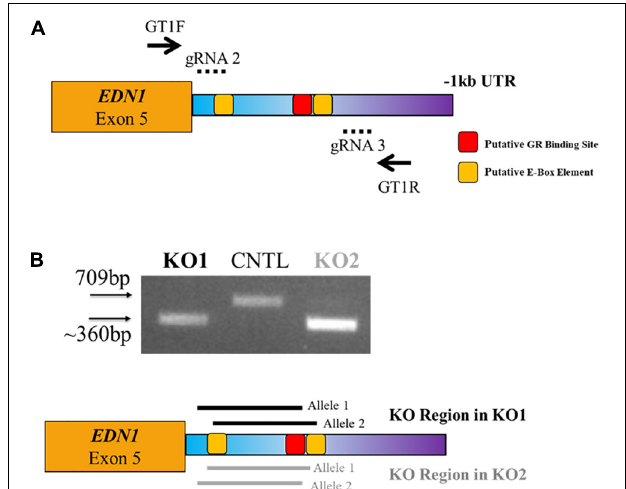
FIGURE 6 | CRISPR/Cas9 Targeted Deletion of GR and E-Box Regulatory Elements within the EDN1-AS Predicted Promoter Region. CRISPR/Cas9 technology was utilized to create biallelic KO of a portion of the predicted Edn1AS promoter region, which contained GR and E-Box regulatory sites. Four guide RNAs (gRNAs) were designed to create deletion of this region (A) . LentiCRISPR was used to deliver the gRNAs to HK2 cells. Puromycin was used to screen cells. Using genotyping primers, GT1F and GT1R (solid arrows), two clones were identified that had a KO of approximately 350 bp generated with gRNAs 2 and 3 (dotted lines) (B) . Sequencing results reviled KO1 has a biallelic KO of 297 bp with 64 bp additional KO 5 (cid:48) of this region on one allele and 78 bp KO 3 (cid:48) of this region on the other allele (black solid lines). KO2 has a biallelic KO of 310 bp with 46 bp additional KO 3 (cid:48) of this region on one allele and 71 bp KO 5 (cid:48) of this region on the other allele (gray solid lines). Both KOs have a deletion of the 1st E-Box response element and the GR element. In addition, we identified control (CNTL) cells that had undergone the CRISPR process, but retained WT copes of the EDN1-AS regulatory region.